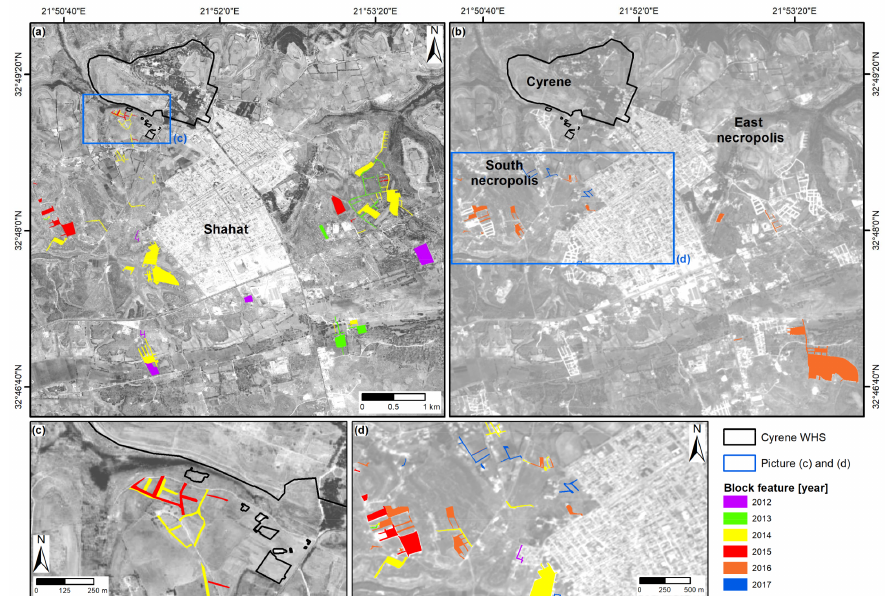
Figure 6. The spatial and temporal distribution of block features of new urban development across the cultural landscape of the Cyrene world heritage site (WHS) and in the surroundings of the modern town of Shahat (Libya), as mapped through ( a ) Google Earth (2009–2015) and ( b ) Sentinel-2 time series (2016–2017). Note that no block features were detected prior to 2012. Zoomed views of the urban development ( c ) close to the Sanctuary of Demeter and Kore and ( d ) west of Shahat, in the landscape of the south necropolis. Blocks in ( a , c ) are overlapped onto Google Earth imagery acquired on 25 December 2006, while blocks in ( b , d ) are overlapped onto Copernicus Sentinel-2 image acquired on 4 October 2015. (© 2015 European Space Agency—ESA). Google Earth imagery © 2018